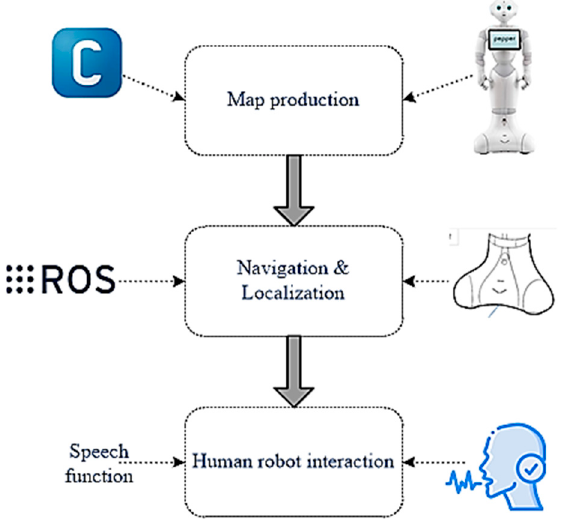
Figure 1. Main phases of the proposed navigation system.